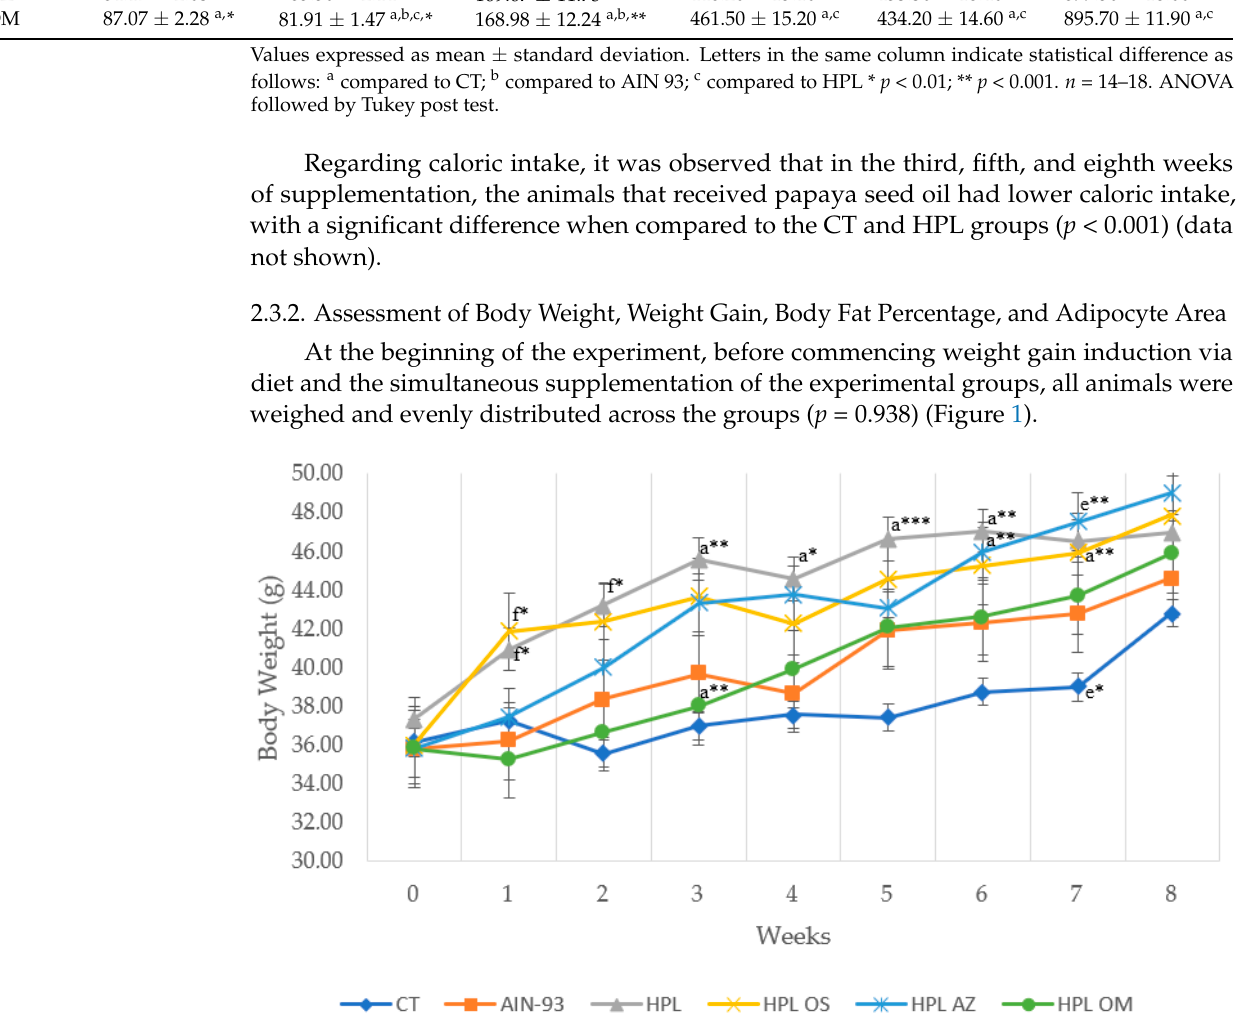
Figure 1. Body weight (g) of animals fed a balanced or high-fat diet and supplemented with saline, soybean oil, olive oil, or seed oil of papaya ( Carica papaya Linn). Values are expressed as mean ± standard deviation. The letters indicate statistical difference as follows: a compared to CT; e compared to HPL AZ; f compared to HPL OM. * p < 0.05; ** p < 0.01; *** p = 0.004. n = 14–18. ANOVA followed by Tukey post test.